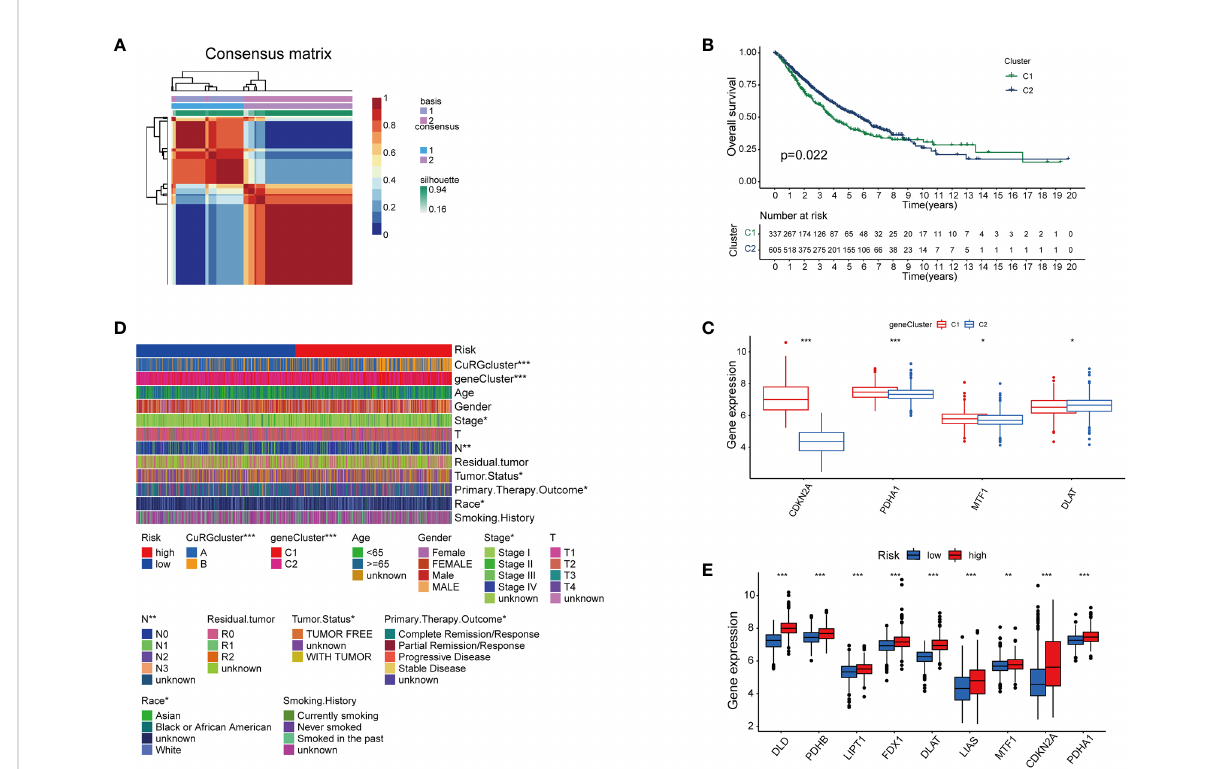
FIGURE 3 The establishment of cupLA panel and the risk assessment potency. (A) Consensus matrix of two LUAD clusters based on cuproptosis-related gene set demonstrated in Figure 2. Based on the sis-gene model, two new LUAD clusters (C1 and C2) were identi fi ed. (B) Kaplan-Meier curves for OS of two C1 and C2. (C) Expression of cuproptosis biomarkers in two LUAD clusters. (D) Heatmap showing clinicopathological features of patients from the high and low-risk groups and the correspondence with the cuproptosis-based gene set. (E) Expression of cuproptosis biomarkers in the high and low-risk group (*, p<0.05; **, p<0.01' ***,